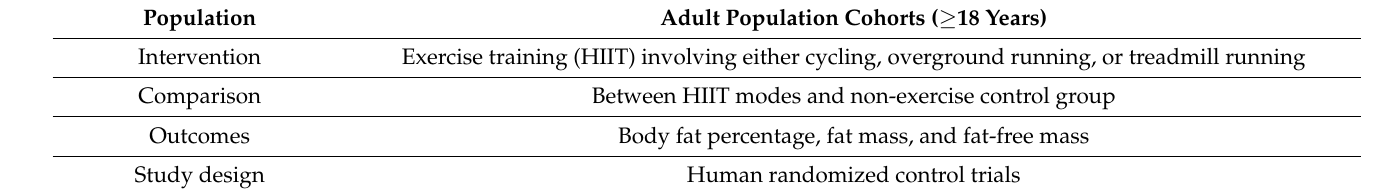
Table 1. Participants, intervention, comparators, outcomes, study design (PICOS) criteria for inclusion of